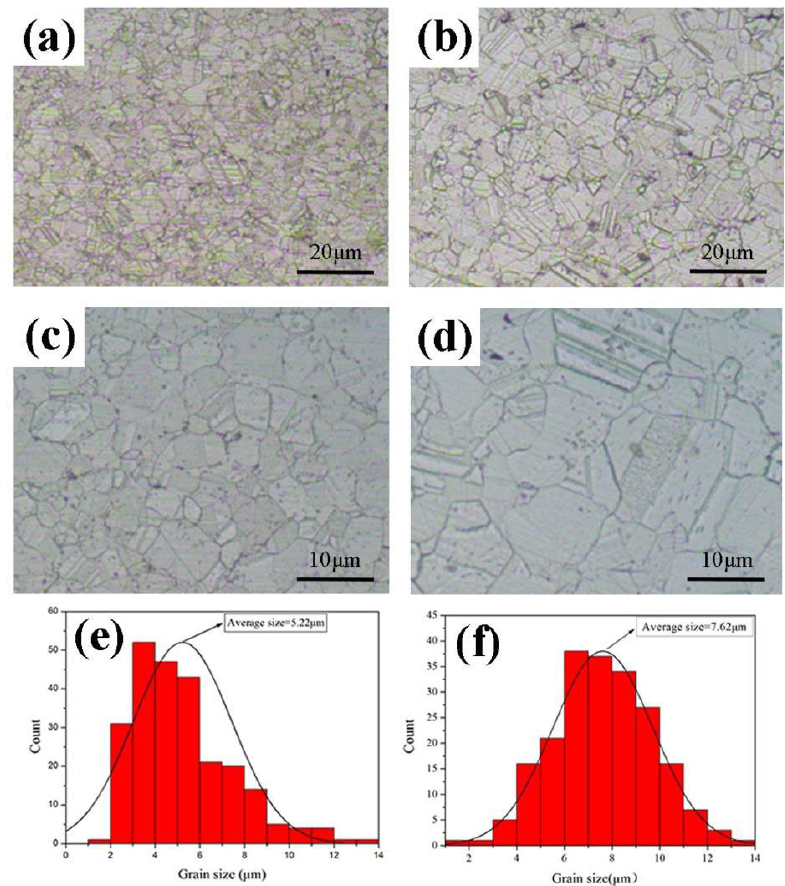
Figure 5. Metallographic observations and statistical charts of the composites: ( a , c , e ) for SPS, ( b , d , f ) for HP.